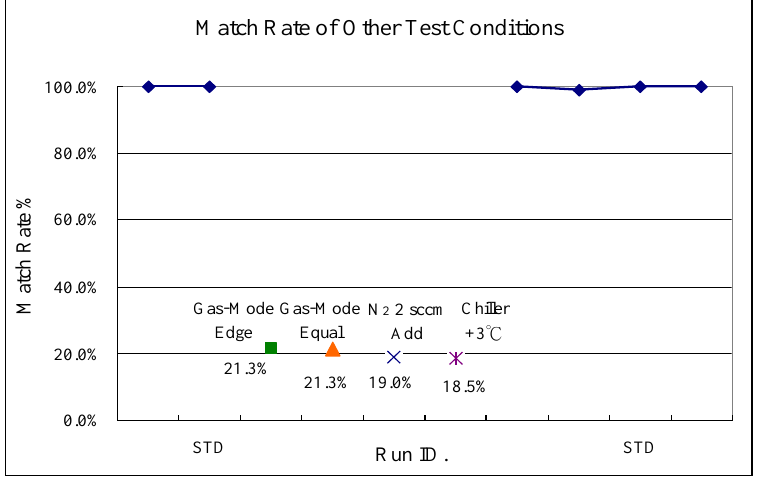
Figure 18. Experiments 9 to 10, gas delivery mode edge changed from equal to edge and center, respectively. Experiment 11, shows adding 2 sccm N experiment 12 shows adjusting ESC temperature from 60 to 63